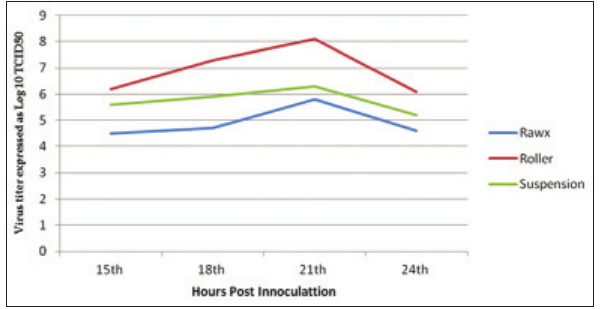
Figure-1: Effect of difference cell culture systems on foot and mouth disease virus serotype (A) infectivity in baby hamster kidney-21 cell line at 37°C.